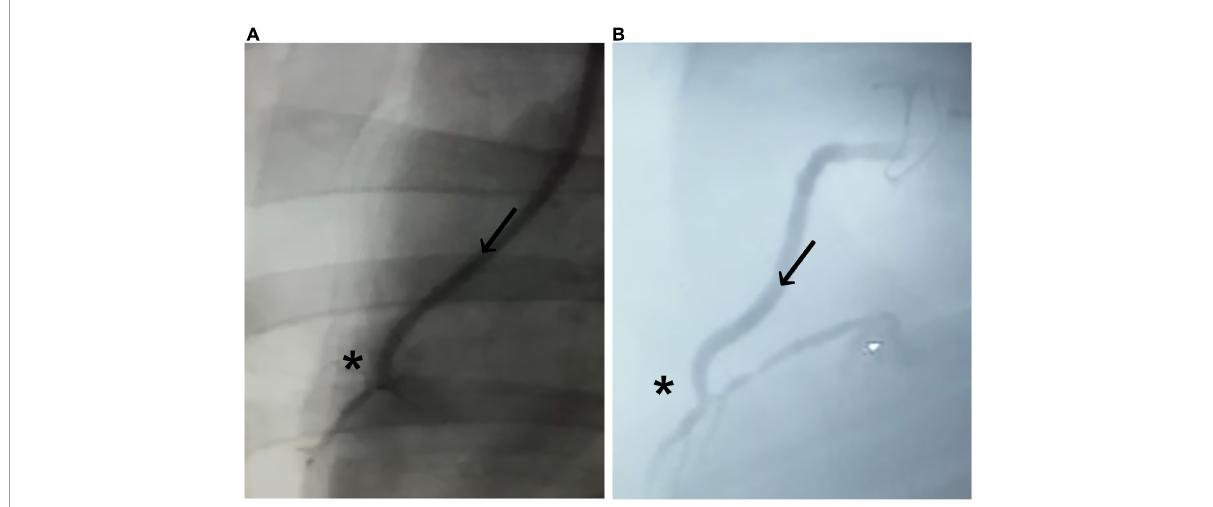
FIGURE3 Coronary angiogram of the implanted graft. (A) Immediately after implantation and (B) 4 weeks after implantation. Bacterial cellulose (BC)-vascular graft shows good postoperative results with a complete patency profile as coronary artery bypass and antegrade flow through the BC graft (arrow in direction of the flow) toward the distal anastomosis (*).